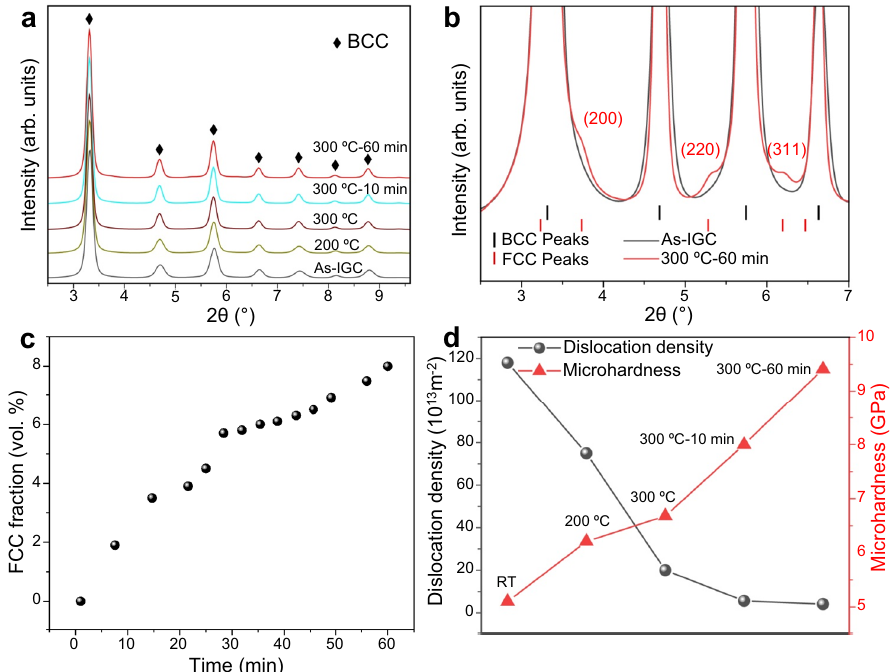
Fig.3|In-situsynchrotronXRDresultsoftheIGCnanograinedFe-Nisamples.a , b SynchrotronXRDpro fi lesoftheIGCFe-Nisample. c EvolutionofthefractionofFCC phase during isothermal heat treatment at 300°C. d Variations of dislocation density and microhardness of the nanograined Fe-Ni